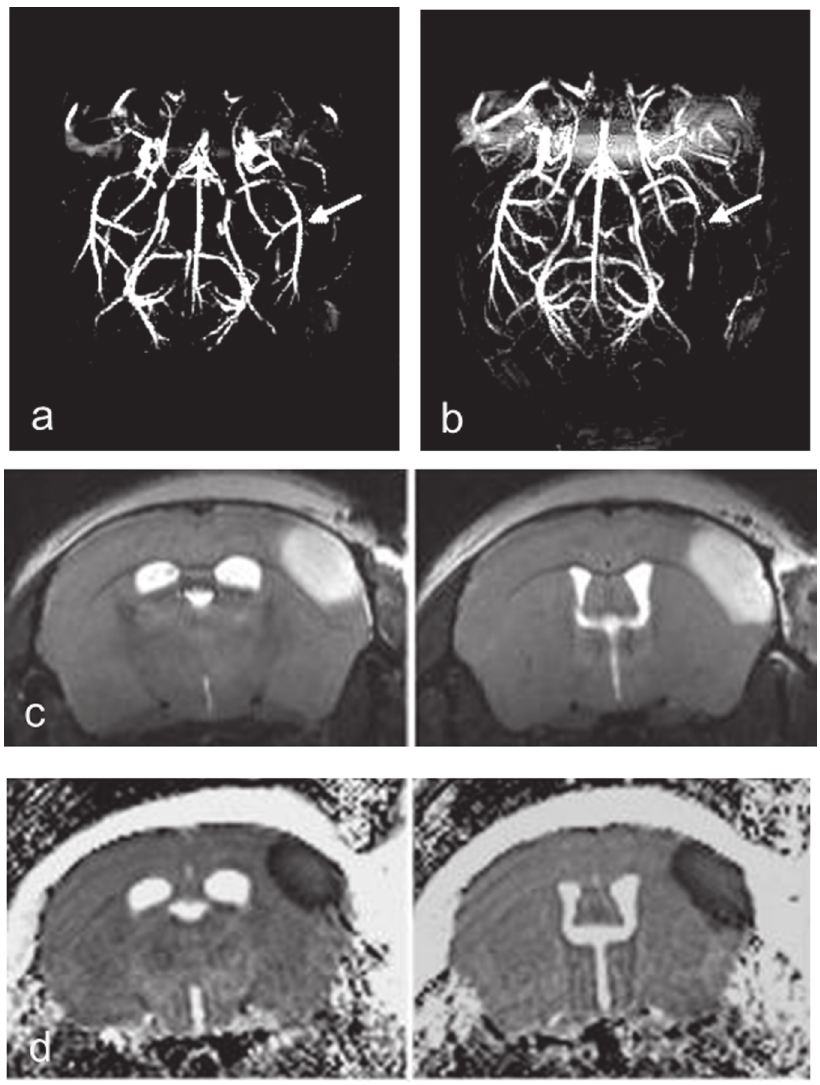
Figure 1. High resolution MR angiography of mouse brain before (a) and after (b) right MCA occlusion (arrows). T2-weighted images (c) and ADC-maps (d) demonstrating infarction.